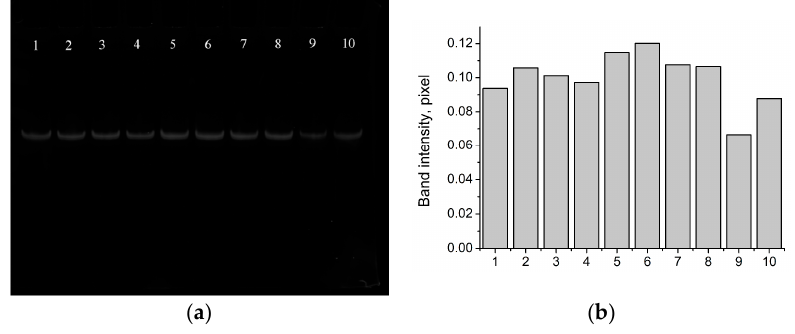
Figure 4. Nondenaturating PAGE (photo without any modification) of PCR amplified (10 cycles) washout probes from magnetic beads modified with DP/Van_74 ( a ) and image analysis of phoresis with GelQuant.NET ( b ) for different vanillin concentrations in low molarity Selection buffer: (1) 1 × 10 − 3 M; (2) 1 × 10 − 3 M, repeat; (3) 2.5 × 10 − 4 M; (4) 2.5 × 10 − 4 M, repeat; (5) 6.25 × 10 − 5 M; (6) 6.25 ×